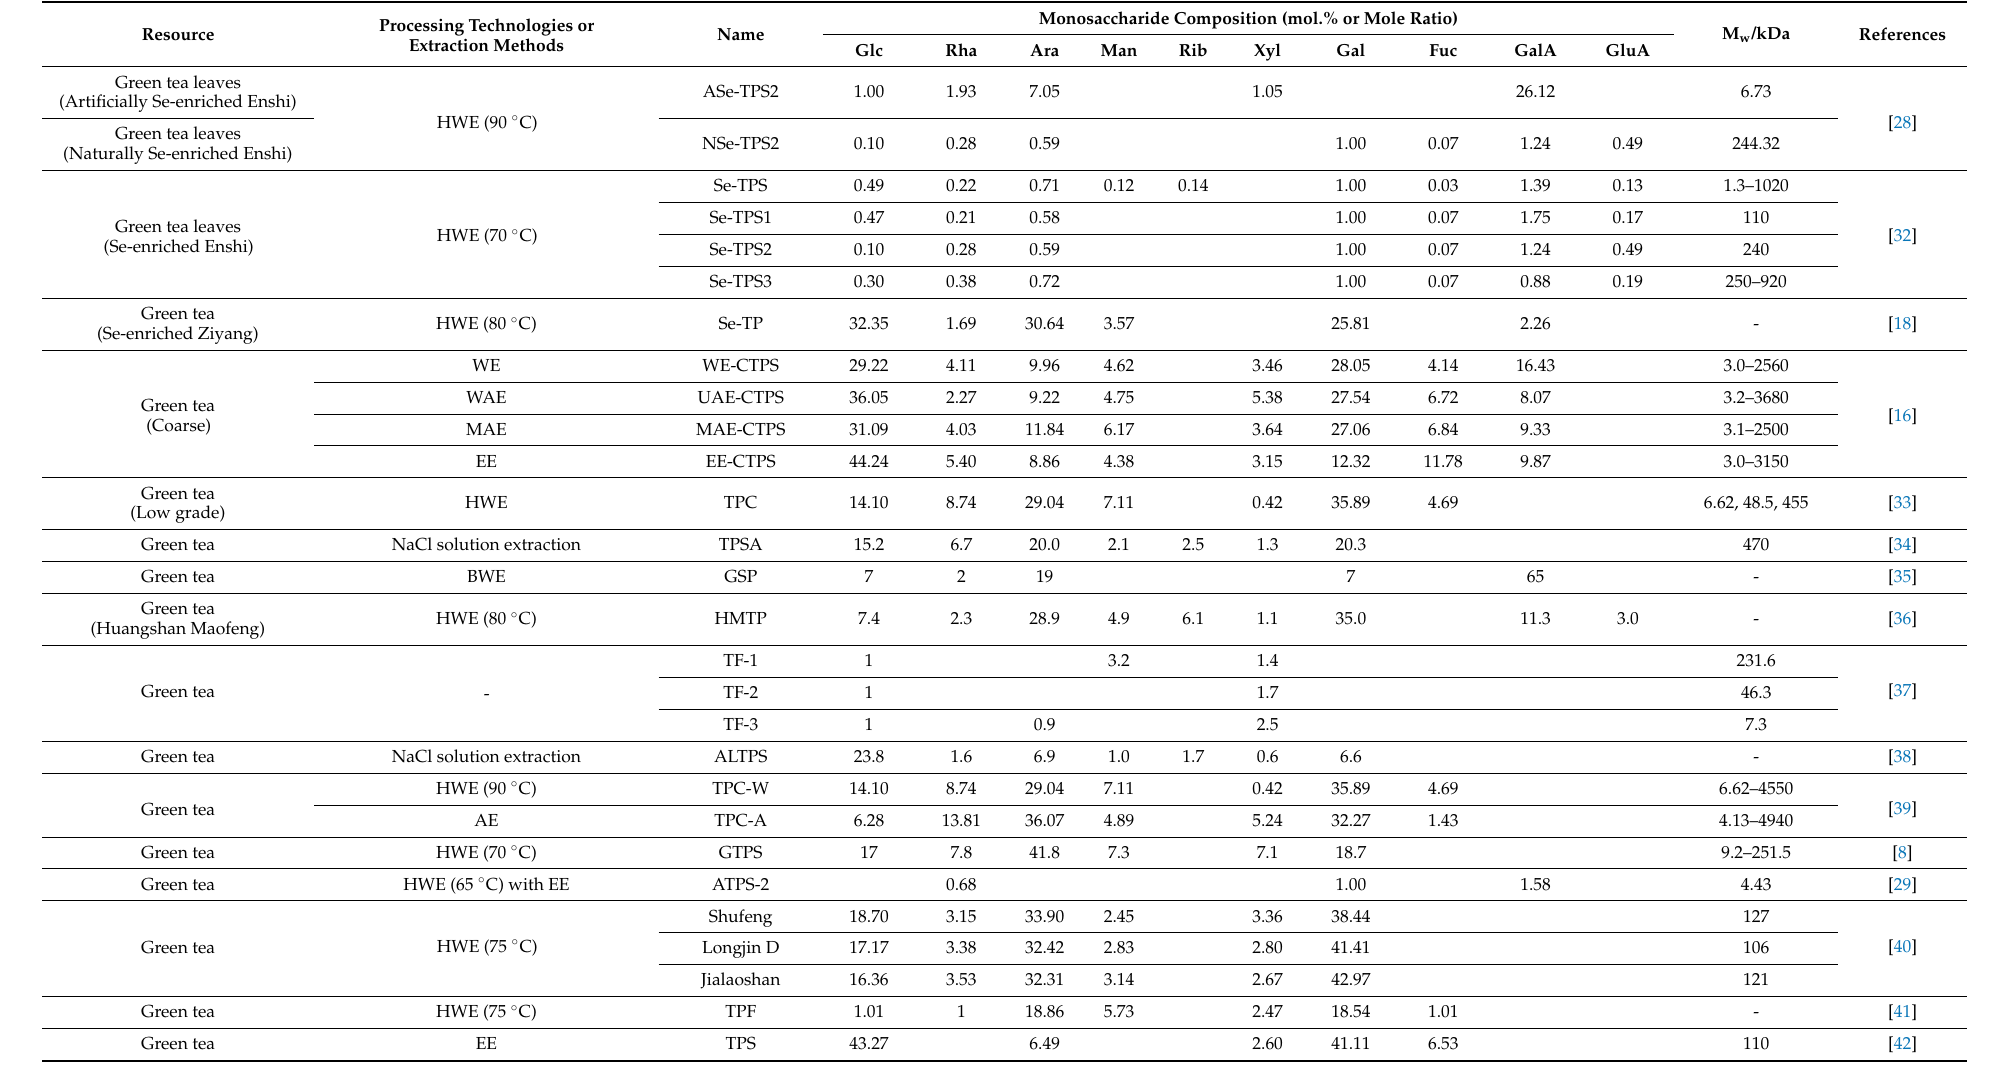
Table 1. Influencing factors on the monosaccharide composition and molecular weight of tea